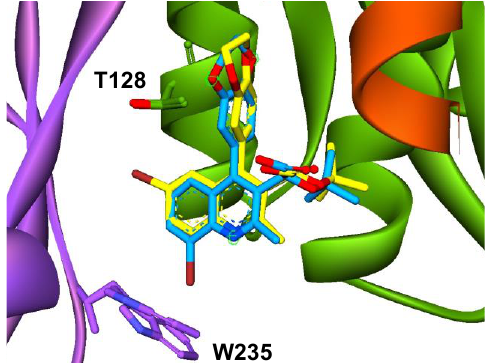
Figure 3. Overlay of the Binding Model of 17 (blue) vs. 16ba (yellow) in A128T.